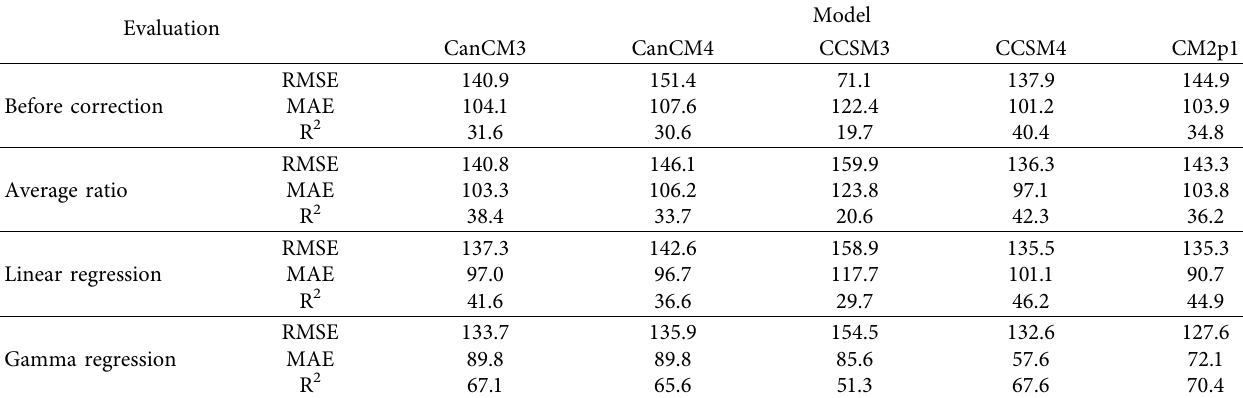
Figure 4: Scatterplots of monthly rainfall observation against NMME forecast. Table 1: Evaluation of NMME data before and after bias